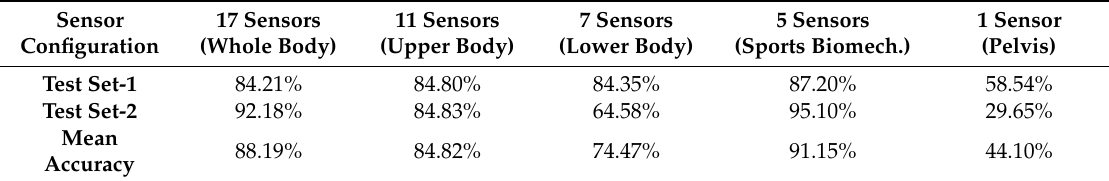
Table 17. Classification accuracies for test set-1 and test set-2 for the five different sensor configurations.